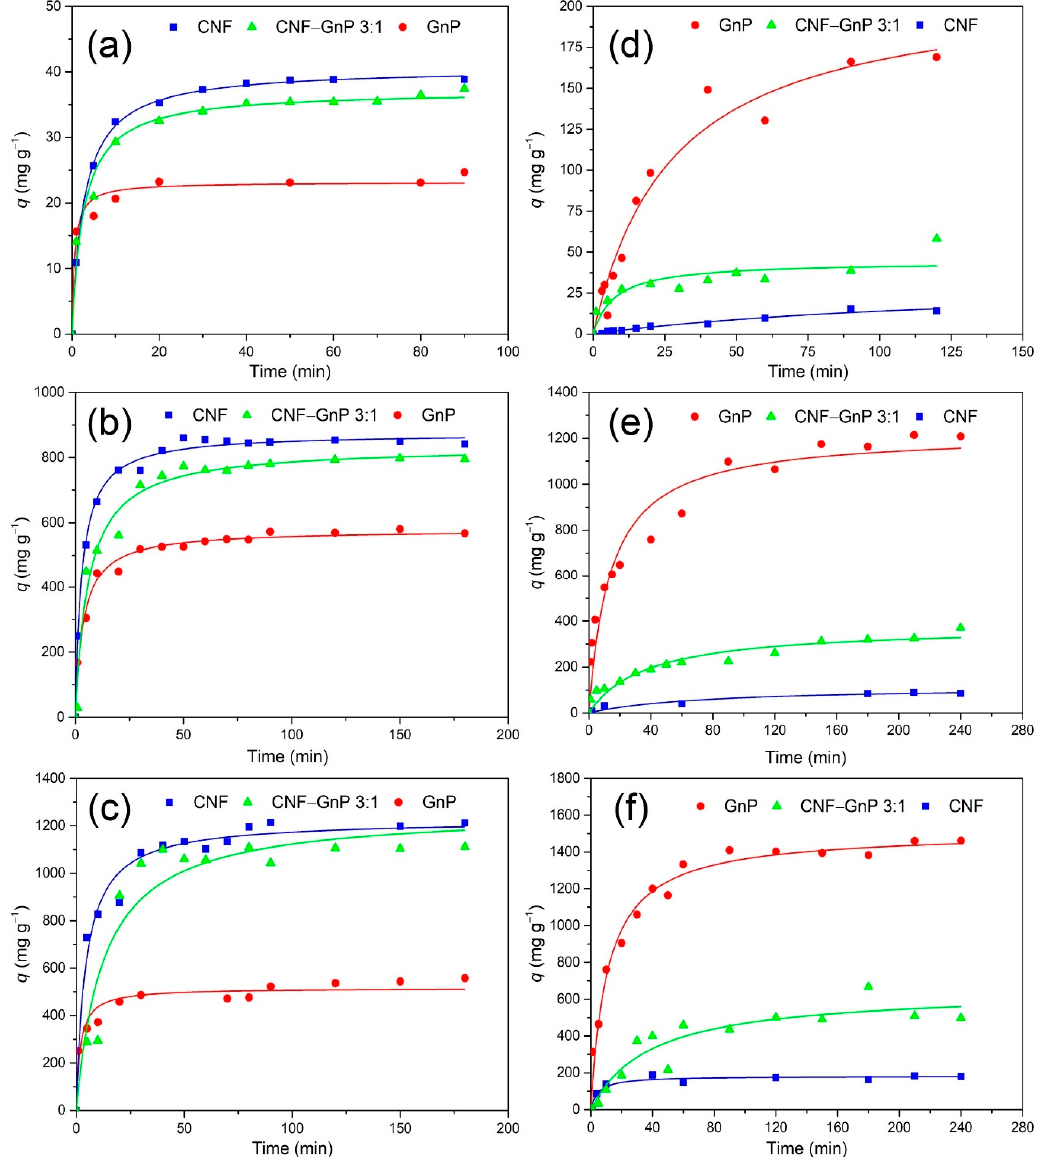
Figure 5. Effects of contact time on the dye removal efficiencies of MB and CR using CNF, CNF–GnP and GnP. Initial MB dye concentration: 10 mg L − 1 ( a ), 250 mg L − 1 ( b ), 500 mg L − 1 ( c ). Initial CR concentration: 100 mg L − 1 ( d ), 600 mg L − 1 ( e ), 2000 mg L − 1 ( f ). Pseudo-second-order adsorption kinetics was applied for all conditions in ( a – f ).